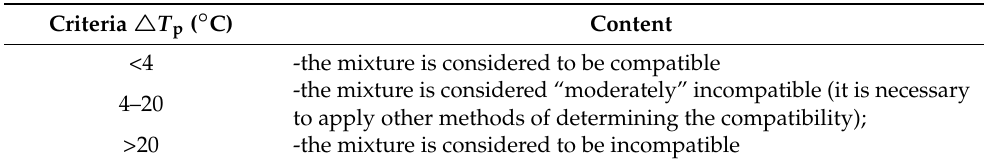
Table 4. Evaluation standards of the compatibility for explosives.